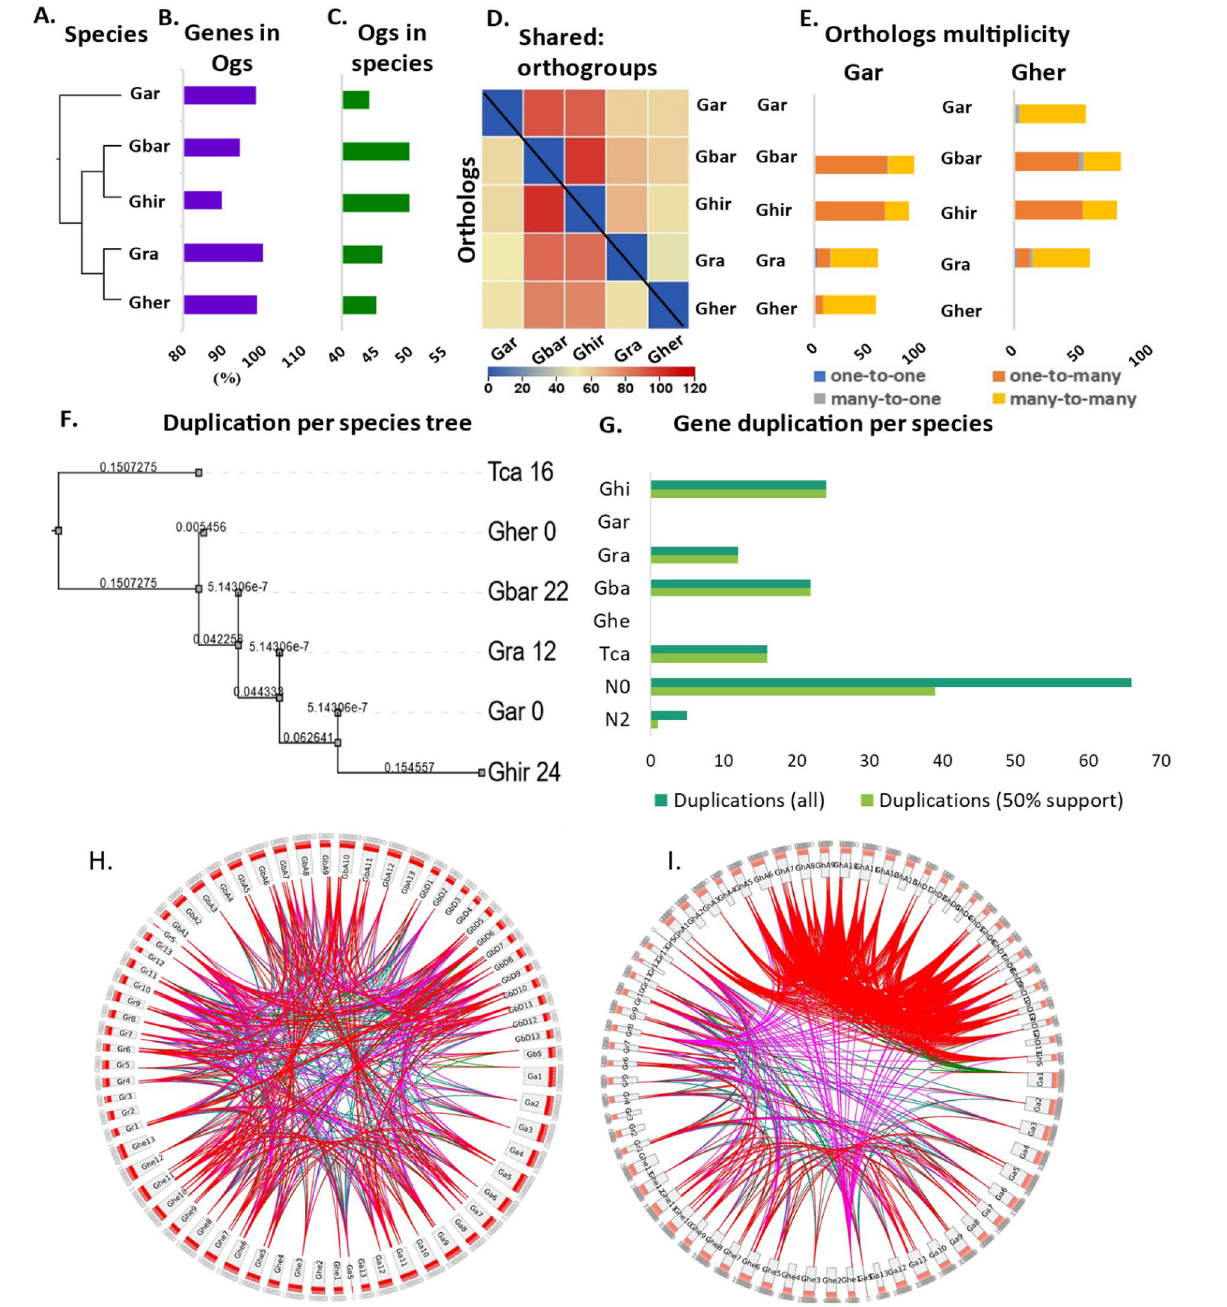
Figure 4. Summary of OrthoFinder analysis of CRK gene family. ( A) The species of Gossypium sp . (B) Percentage of genes in orthogroups. ( C) The number of species-specific orthogroups. ( D) Heat map showing shared orthogroups. ( E) Orthologs multiplicity. ( F) Gene duplication events per species. ( G) Gene duplication per internal and terminal nods of the species-based-phylogenetic tree. ( H ) Circos plot of Gar, Gher, Gra with Gbar . ( I) Circos plot of Ghir with Gar, Gher and Gra . Tca ; T. tissue. These differential expressions indicate the role of CRK genes in the growth and development of multiple tissues (Fig. 5A, Tables S15–S16). The RNA-seq data of CRK genes under different abiotic stresses including salt, drought, heat, and cold stresses was demonstrated at different time intervals (1 h, 3 h, 6 h, and 24 h) and days intervals (0 DPA, 1 DPA, 3 DPA, 10 DPA, 15 DPA, and 20 DPA) (Tables S17–S21). The comparative expression profiling revealed several differentially expressed gene clusters displaying increased transcripts values at corresponding stress conditions. For instance, a cluster of genes including GhCRK060, GhCRK053, GhCRK083, and GhCRK110 showed high expression under all stresses including salt, drought, heat, and cold. However, most of the CRKs depicted tissue-specific expressions. For instance, GhCRK109 was highly expressed under salt stress while did not show induced in other stresses.